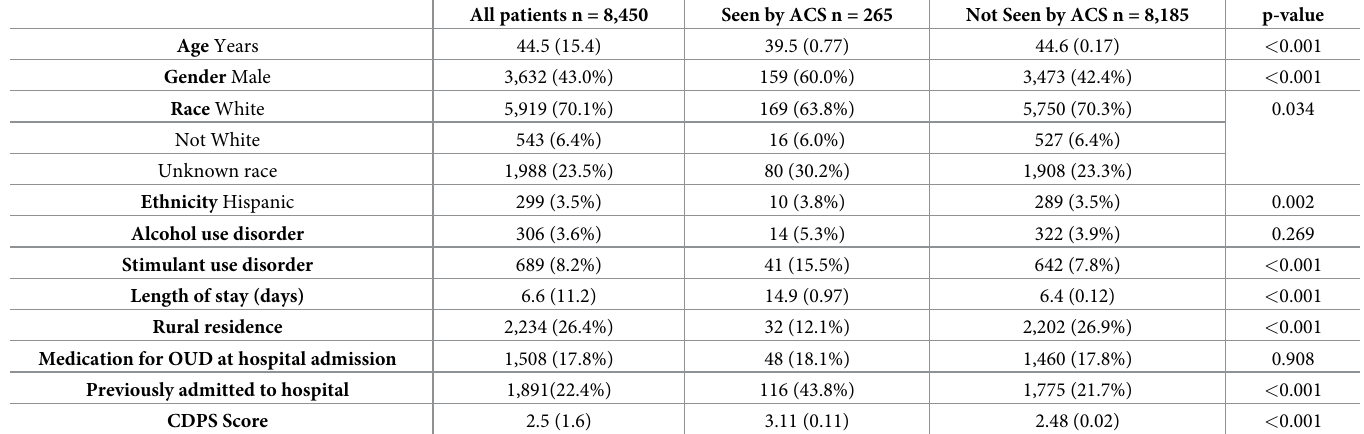
Table 1. Participant